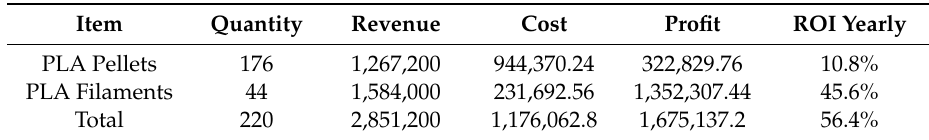
Table 6. Expected returns on investments